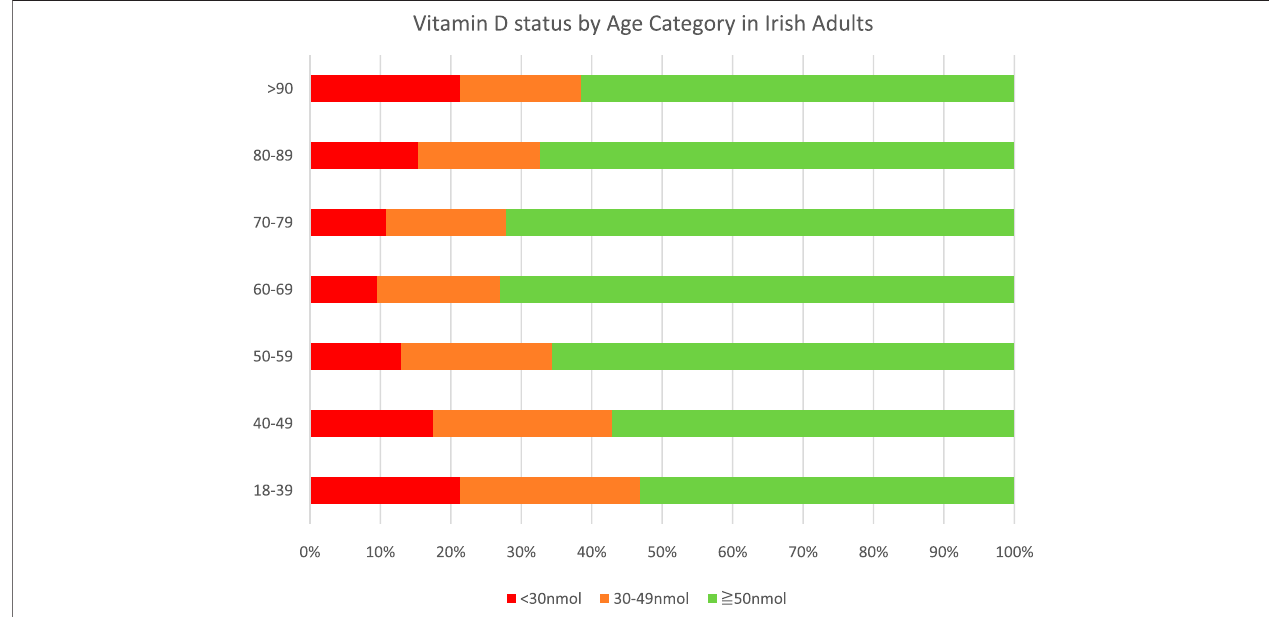
FIGURE 3 | Prevalence of vitamin D de fi ciency and vitamin D levels < 50 nmol/L in Irish adults (n = 36,466) (Adapted from Scully et al., 2020).